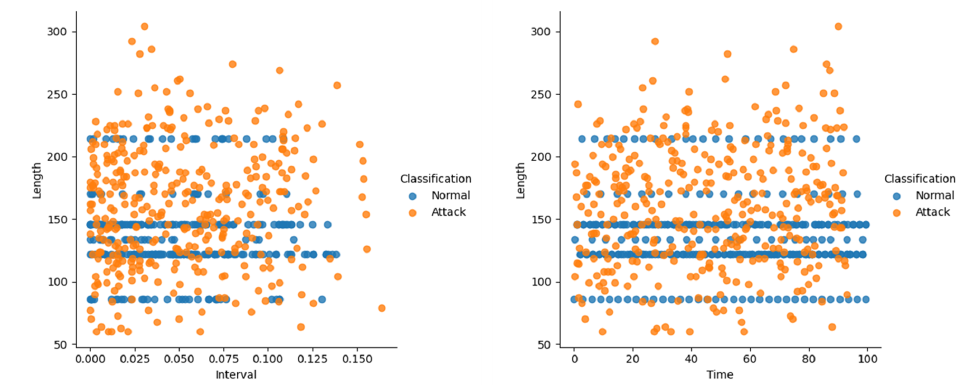
Figure 4. 2D scatter of Gaussian Spreading based attack with only small packets.